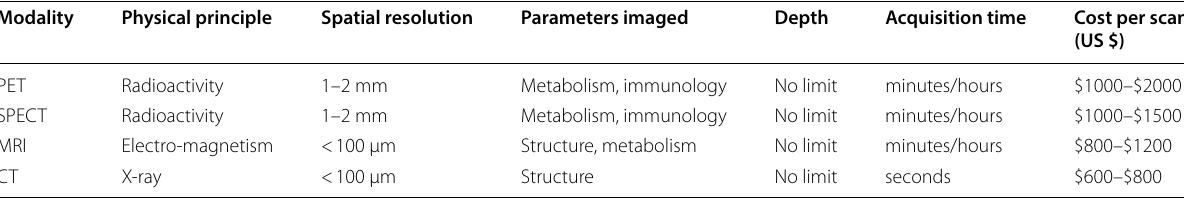
a Cost per scan may vary depending on the injected dose price. Adapted from [52]